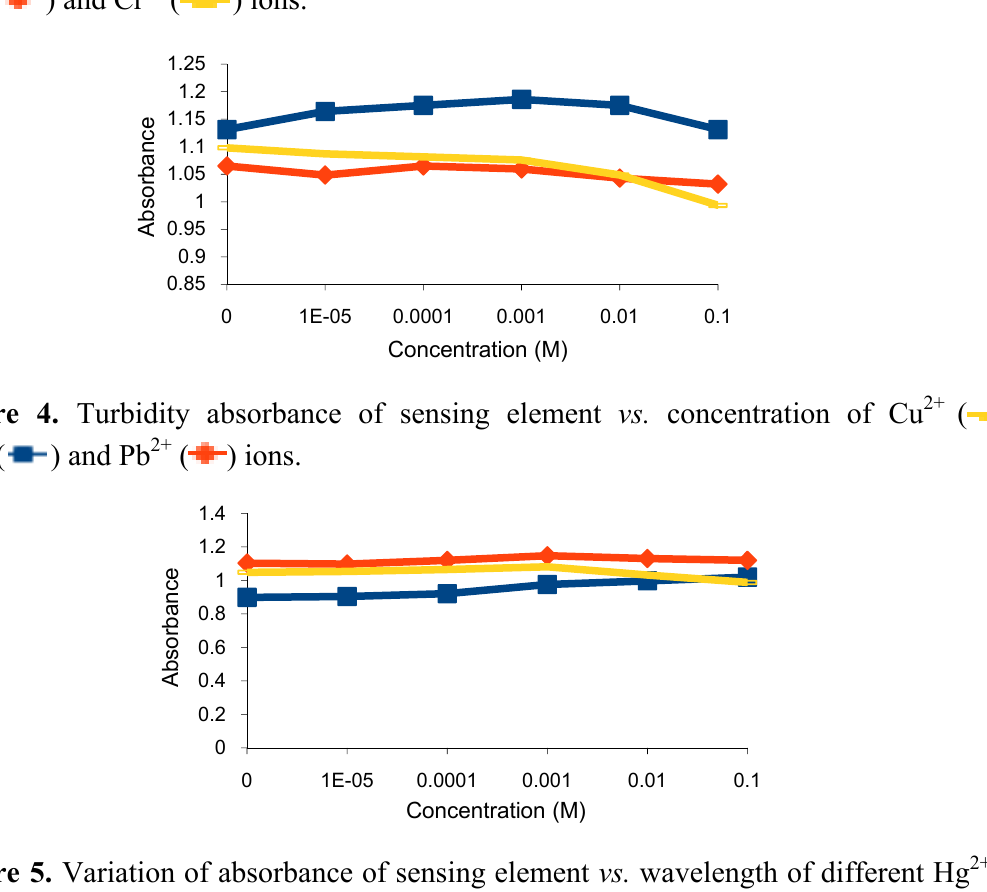
Figure 3. Turbidity absorbance of sensing element vs. concentration of Zn 2+ ( ), Ni 2+ ( ) and Cr 3+ ( ) ions.